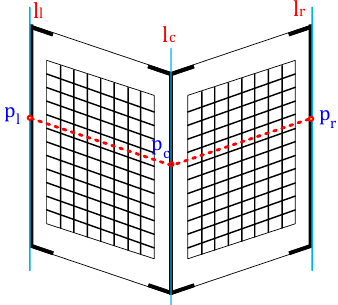
Figure 2. Calibration board description used for the extrinsic calibration: the blue lines (left ( l l ), center ( l c ) and right ( l r )) describe the line feature that we extracted in the image, and the three red points ( p l , p c , p r ) are the point features in 3D. The checker pattern on each plane is utilized for the joint